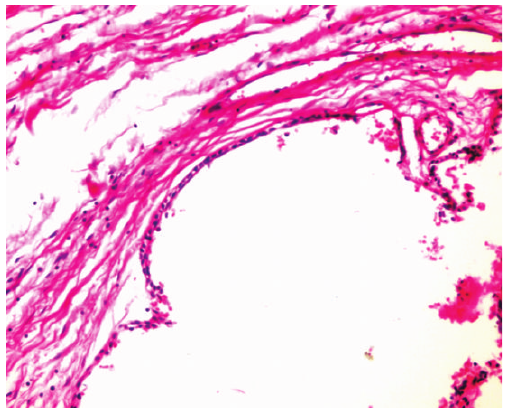
Figure 5: Cystic area lined by 1-2 cell layers thick of cuboidal cells (H&E, ×